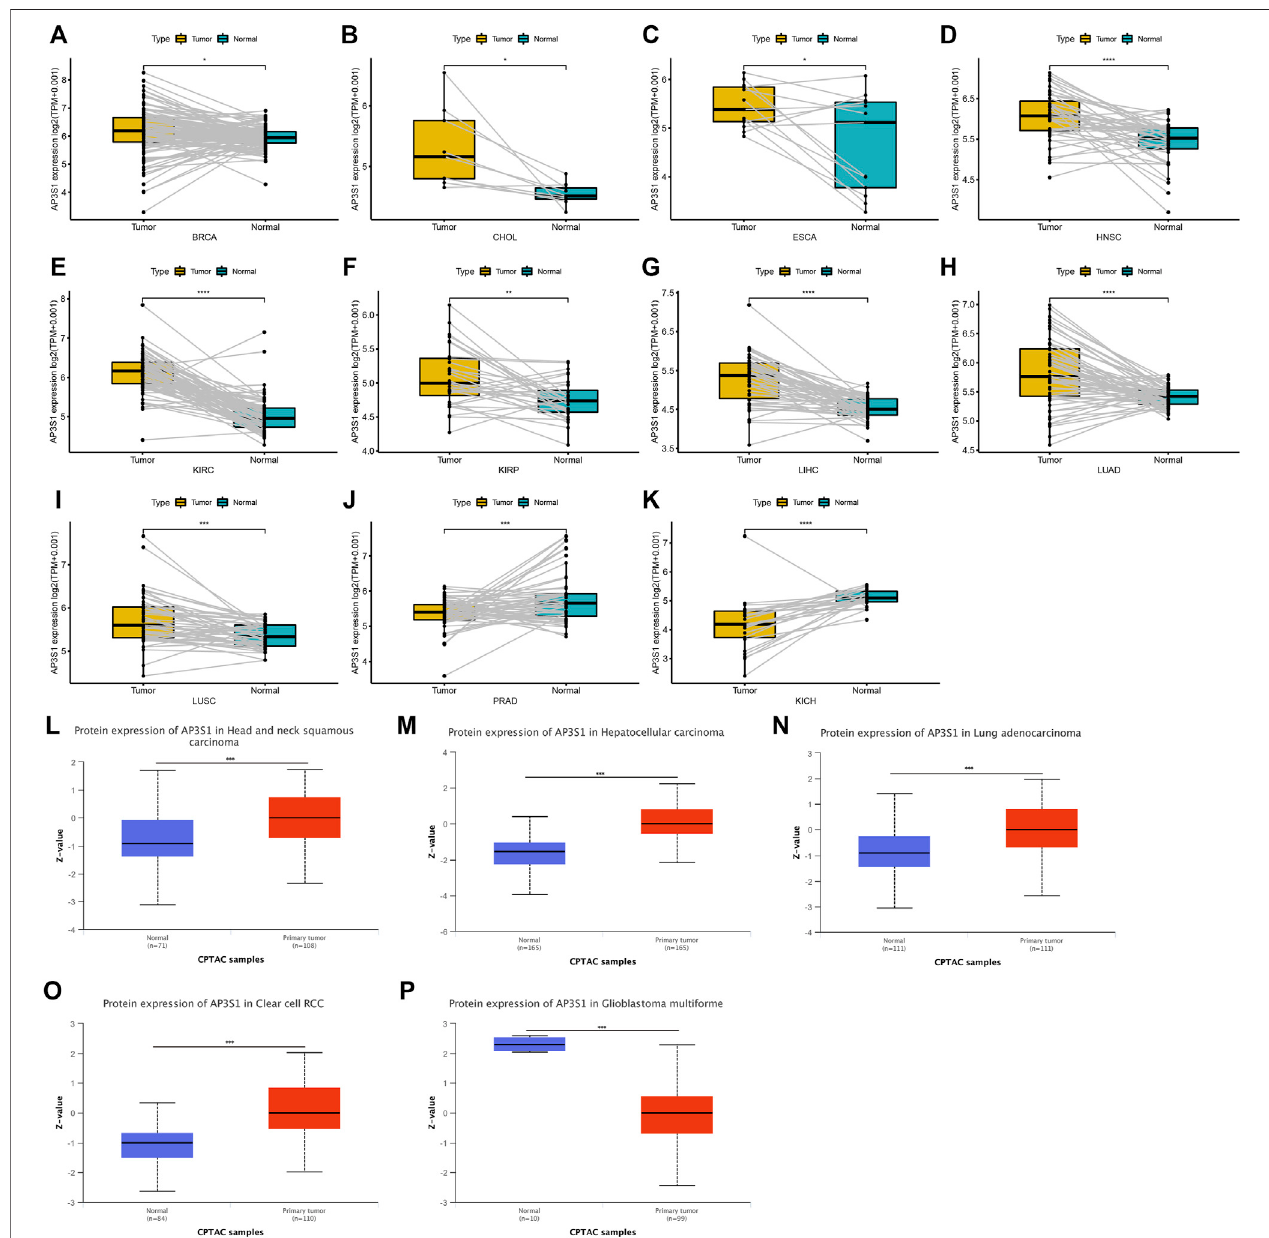
FIGURE2| ExpressionofAP3S1inpairedtumorandadjacentnormaltissues. (A – K) AP3S1expressioninpairedtumorandadjacentnormaltissuesfromTCGAin indicated tumor types. (L – P) The protein level of AP3S1 in indicated tumor types using Ualcan database* p < 0.05, ** p < 0.01, *** p < 0.001, **** p < 0.0001.